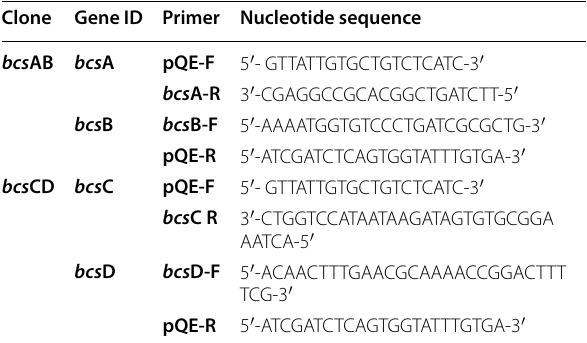
Table 1 List of primers used for screening of bcsAB and bcsCD- positive transformants for correct orientation downstream T5 promoter in pQE‑Trisystem expression vectors Clone Gene ID Primer Nucleotide